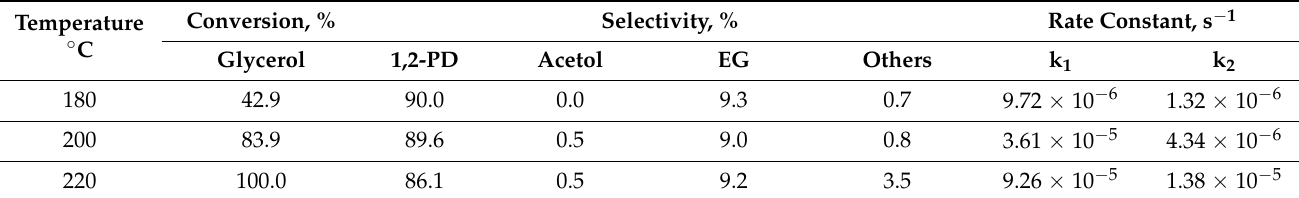
energies and pre-exponential factors for the three reactions were listed in Table A7. Table A5. Glycerol hydrogenolysis with molecular hydrogen at three temperatures a